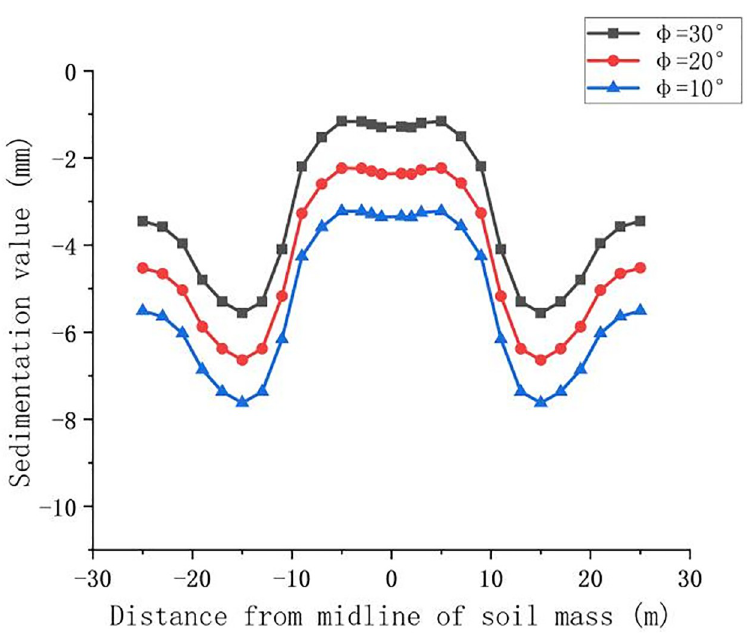
Fig 21. Deformation curve caused by the change in the internal friction angle.